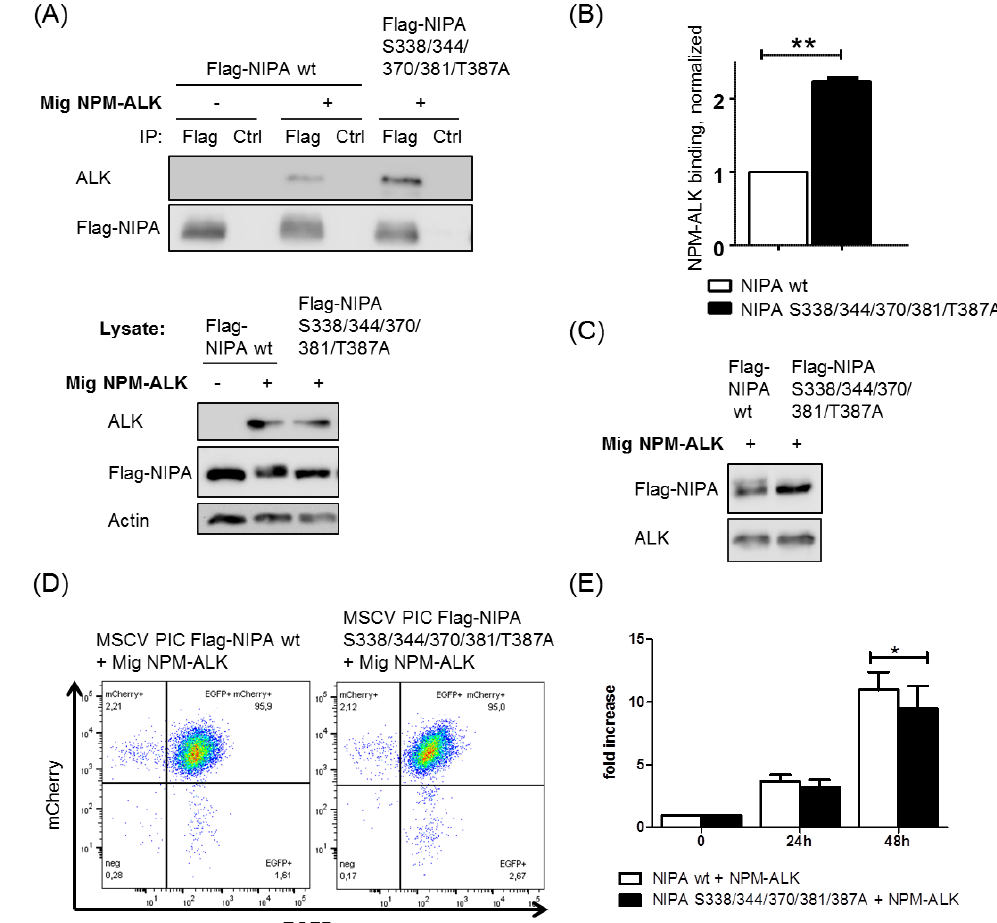
Figure5. NIPAphospho-deficiencyleadstoenhancedNPM-ALKbindingandimpairedcellproliferation in NPM-ALK positive cells. ( A ) HEK293T cells were transiently transfected with pCDNA Flag hNIPA wt or pCDNA Flag hNIPA S338 / 344 / 370 / 381 / 387A +/ − Mig NPM-ALK and used for Flag-IP. ( B ) Quantification of three independent experiments showed increased NPM-ALK binding ability to phospho-deficient NIPA S338 / 344 / 370 / 381 / 387A (** p < 0.01). ( C ) Ba / F3 cells were stably transfected with MSCV PIC Flag hNIPA wt or MSCV PIC Flag hNIPA S338 / 344 / 370 / 381 / 387A +/ − Mig NPM-ALK. WB and ( D ) FACS analysis confirmed NIPA-mCherry and NPM-ALK-EGFP expression. ( E ) MTS assays were performed with 5000 cells and triplicates to evaluate the proliferative potential of the cells. Quantification of three independent MTS assays showed impaired growth in NPM-ALK + BaF3 cells with NIPA S338 / 344 / 370 / 381 / 387A within 48 h (* p <